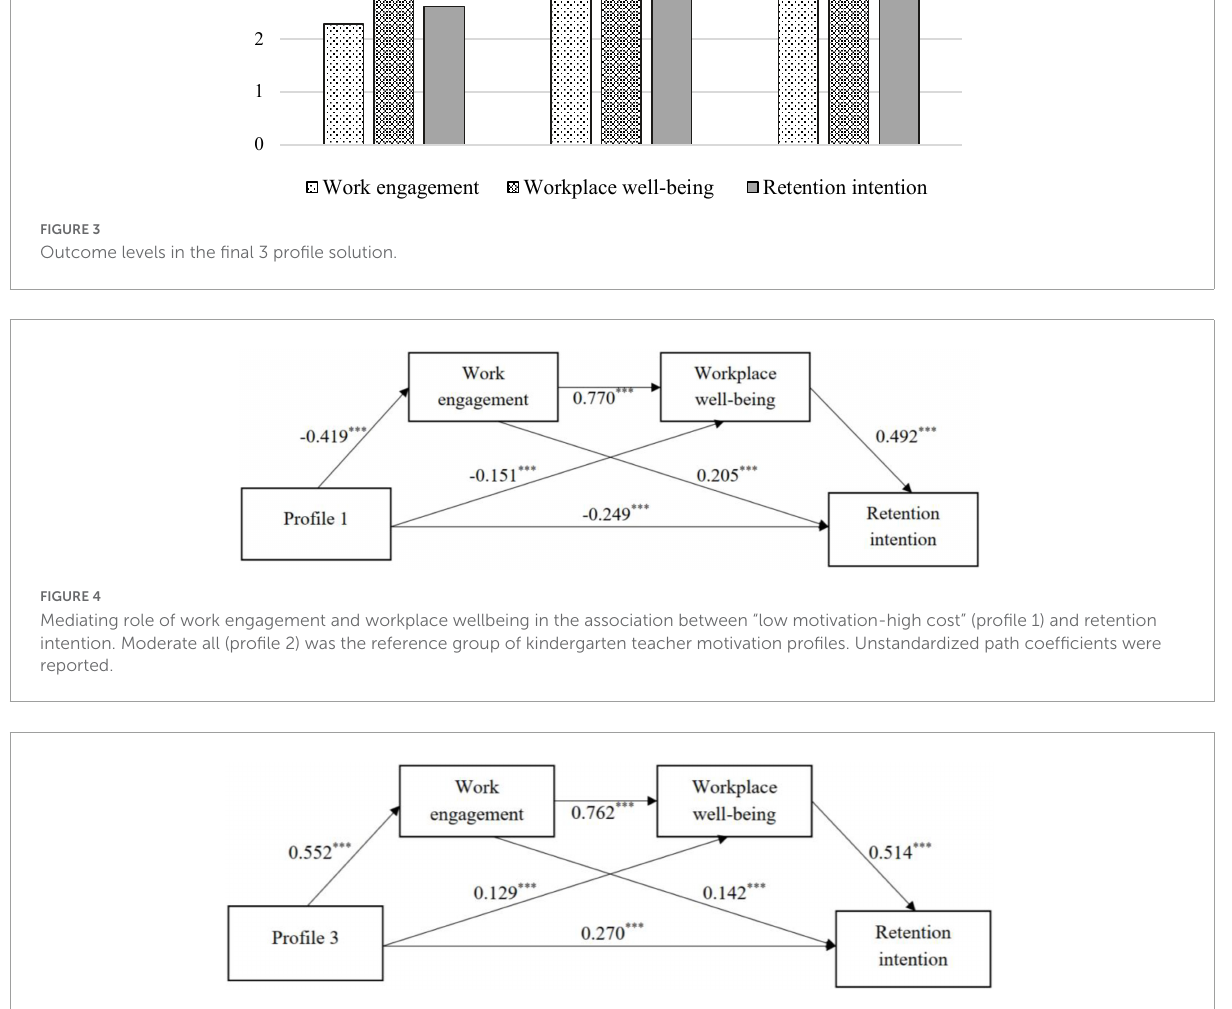
FIGURE5 Mediating role of work engagement and workplace wellbeing in the association between “high value-low cost” (profile 3) and retention intention. Moderate all (profile 2) was the reference group of kindergarten teacher motivation profiles. Unstandardized path coefficients are